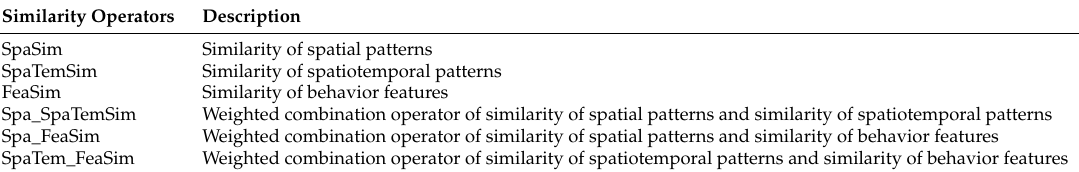
Table 1. Description of all similarity